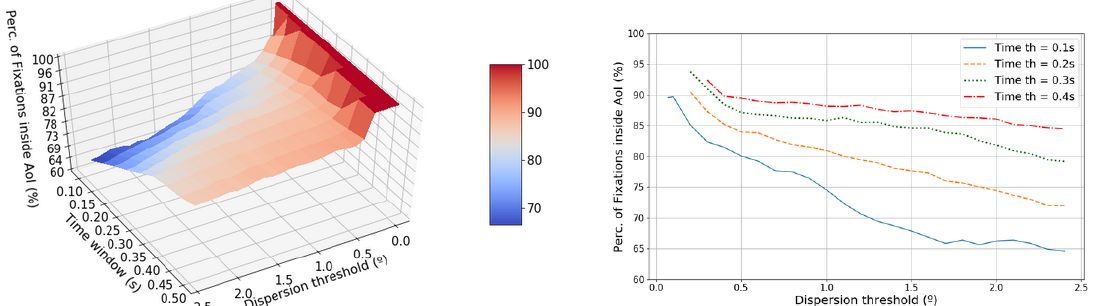
Figure 7. The left-hand graphic shows the evolution of the percentage of fixations inside Area of Interest (AoI) in terms of the dispersion threshold and the time window. The right-hand graphic shows the projected dispersion